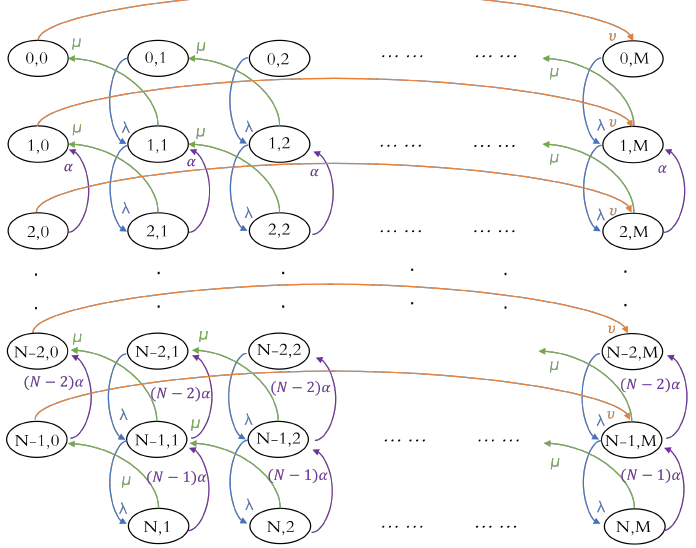
Figure 2. Rate diagram for finite queuing inventory models with impatient customers under a deterministic order